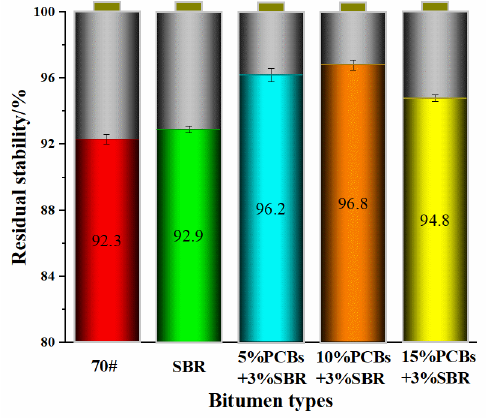
Figure 9. Marshall test results of residual stability.